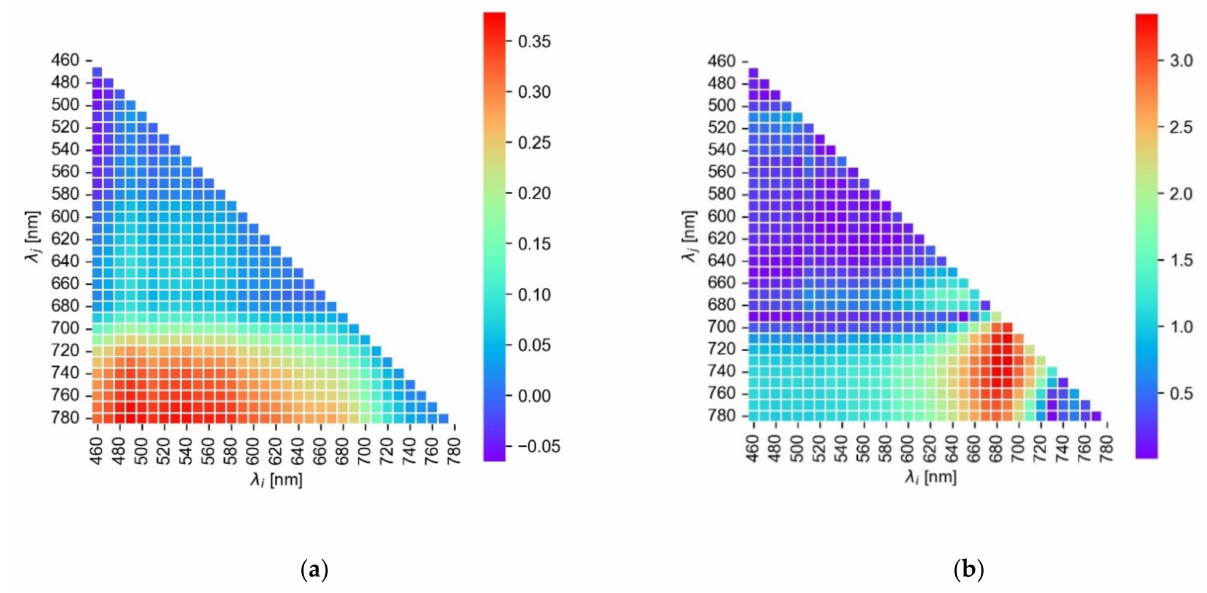
Figure 5. ( a ) Threshold values of NDSI and ( b ) the Mahalanobis distances, calculated for all combina- tions of the spectral